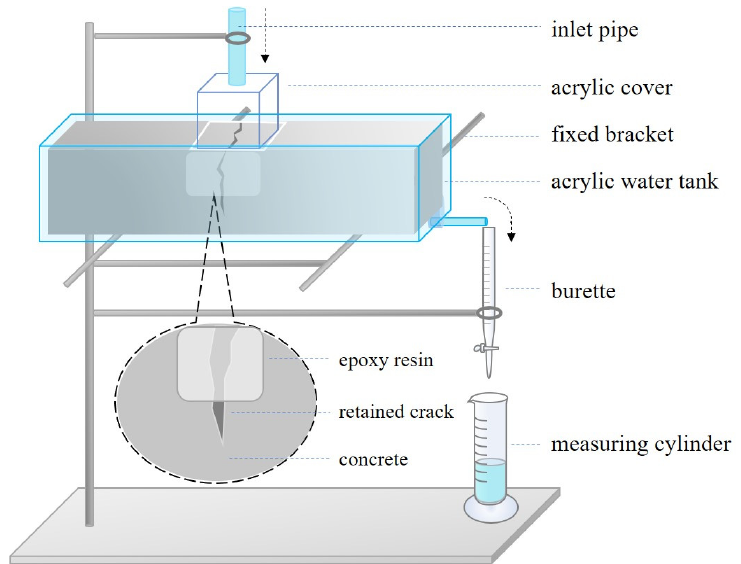
Figure 8. Schematic diagram of the specimen water penetration test device.